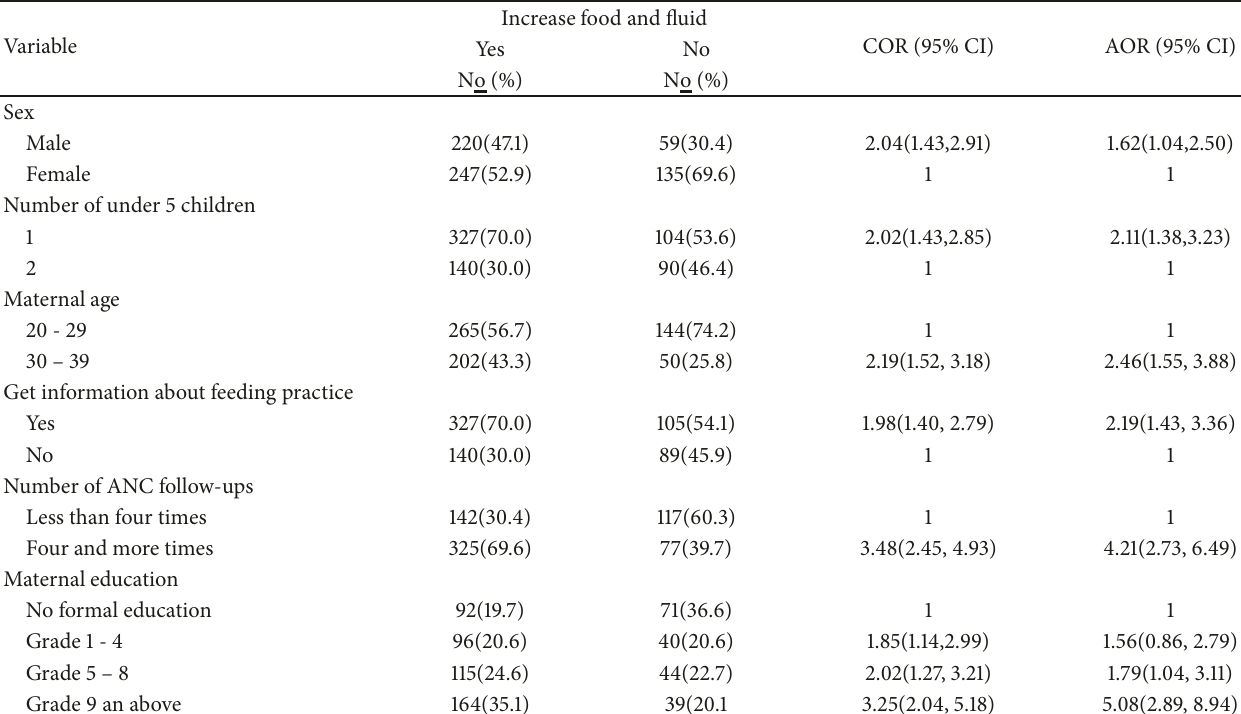
Table 3: Predictors of feeding practice during diarrheal episode in Mirab Abaya district, Gamo Gofa Zone, SNNPR, March